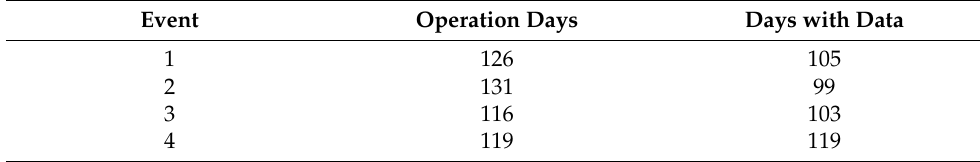
Table 1. Events for cross-validation.